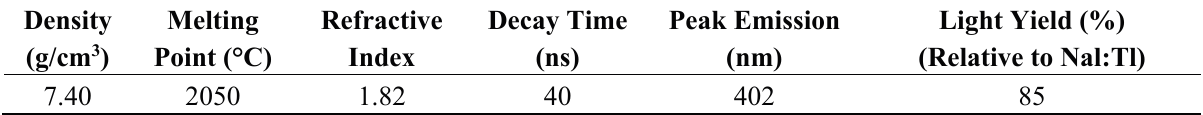
Table 1. Physical properties of LYSO:Ce crystal.